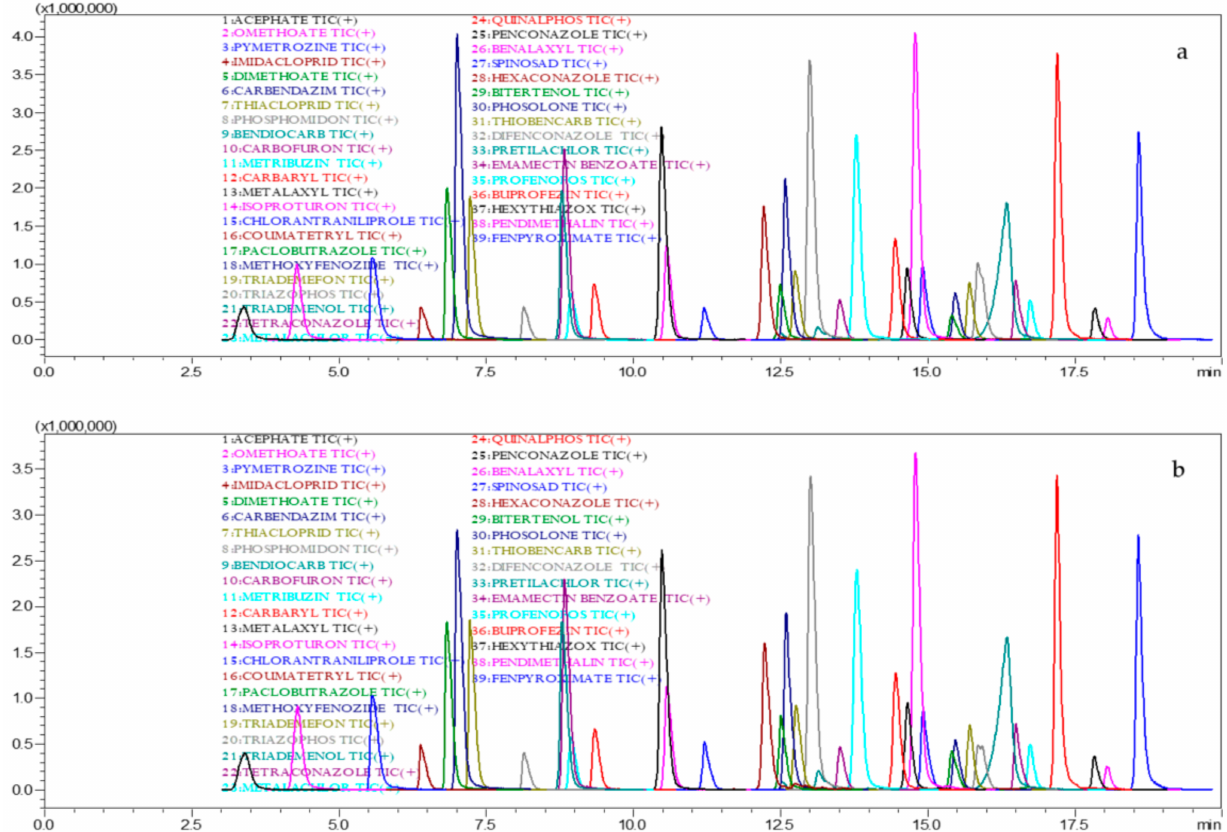
Figure 3. LC-MS/MS chromatogram for recovery in capsicum ( a ) and tomato ( b ) at 0.1 mg kg − 1.